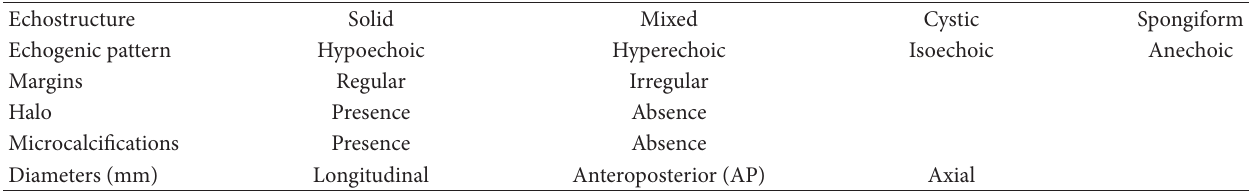
Table 1: Ultrasonographic features evaluated in each thyroid nodule.